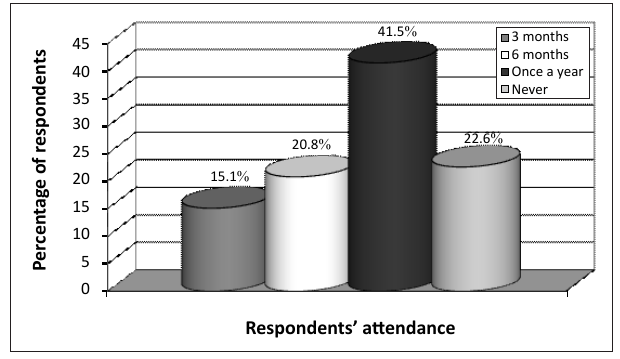
As prescribed Feel